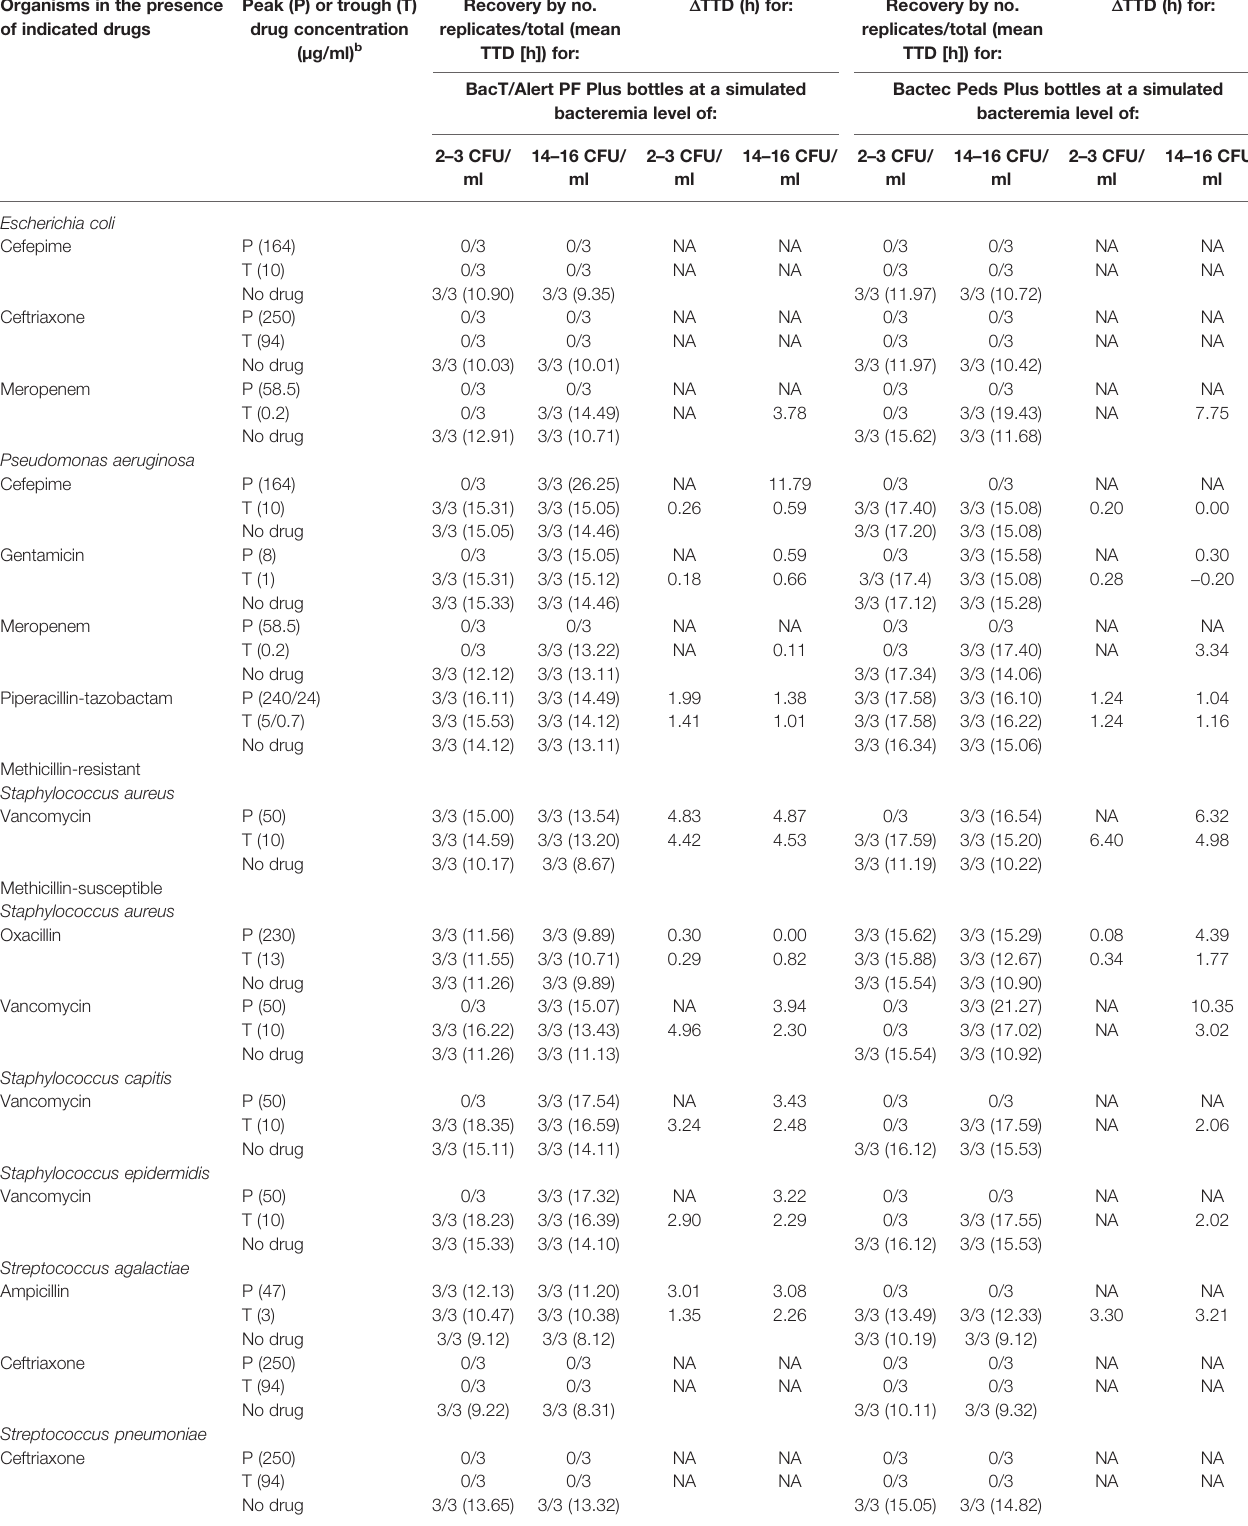
TABLE 1 | Detection results of organisms in resin-containing BacT/Alert or Bactec pediatric blood culture bottles according to antimicrobial drug and relative concentration. a